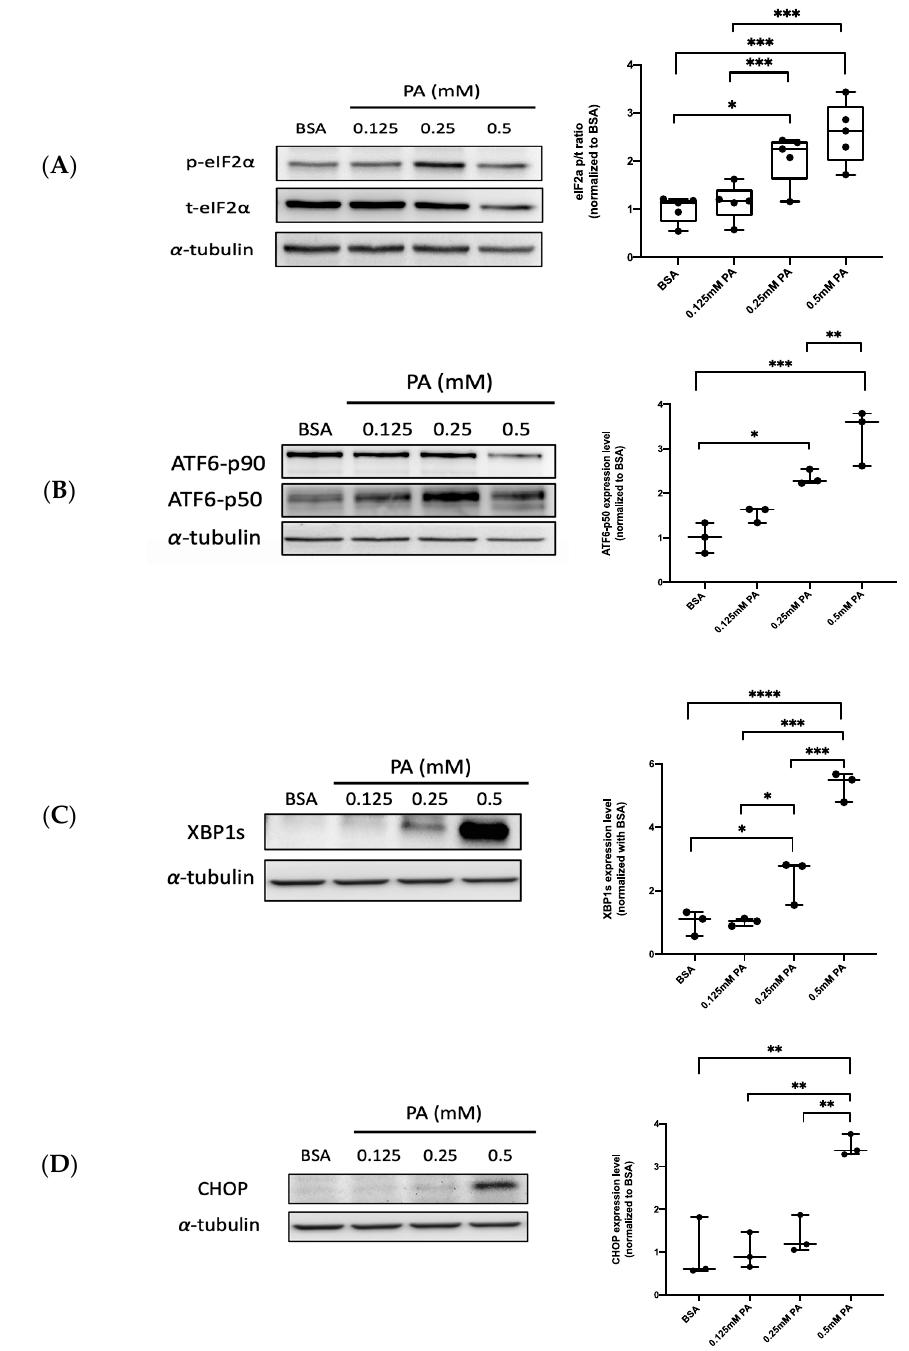
Figure 1. PA activates three pathways of unfolding protein response (UPR) signaling in HUVECs. PA was administered to HUVECs in different concentrations (0.125–0.5 mM) for 24 h. The protein expression of ER stress-related UPR markers, including ( A ) phosphorylated and total eIF2 α , ( B ) ATF6, ( C ) spliced XBP1, and ( D ) CHOP, was analyzed using Western blotting and quantified. Data are presented as the mean ± SEM obtained from three independent groups. Data from multiple groups were analyzed by one-way ANOVA, followed by Tukey’s post hoc test. * p < 0.05, ** p < 0.01, *** p < 0.001, **** p < 0.0001.